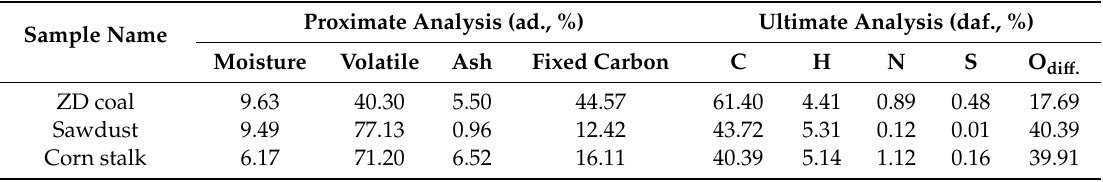
Table 2. Proximate and ultimate analysis of the origin sample. (Note: Diff. = by difference, ad. = air dry basis, daf. = dry ash-free basis).